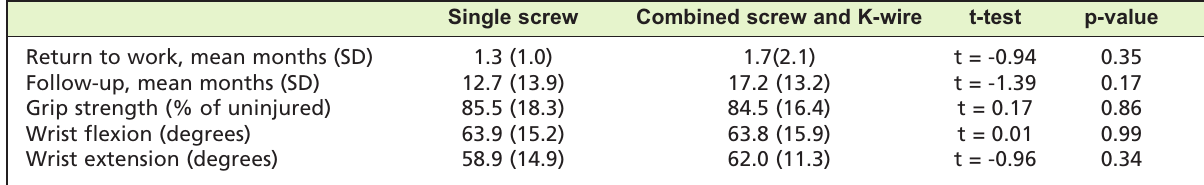
Post-operative outcomes Table III: